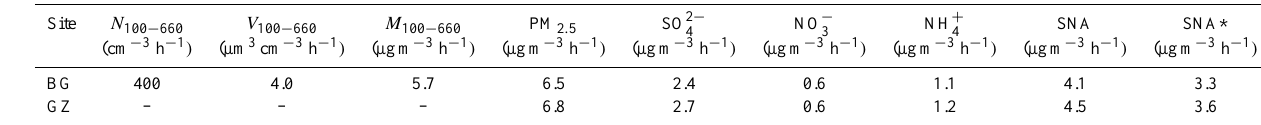
Table 3. Increase rates of major species during the nighttime accumulation pollution episode.